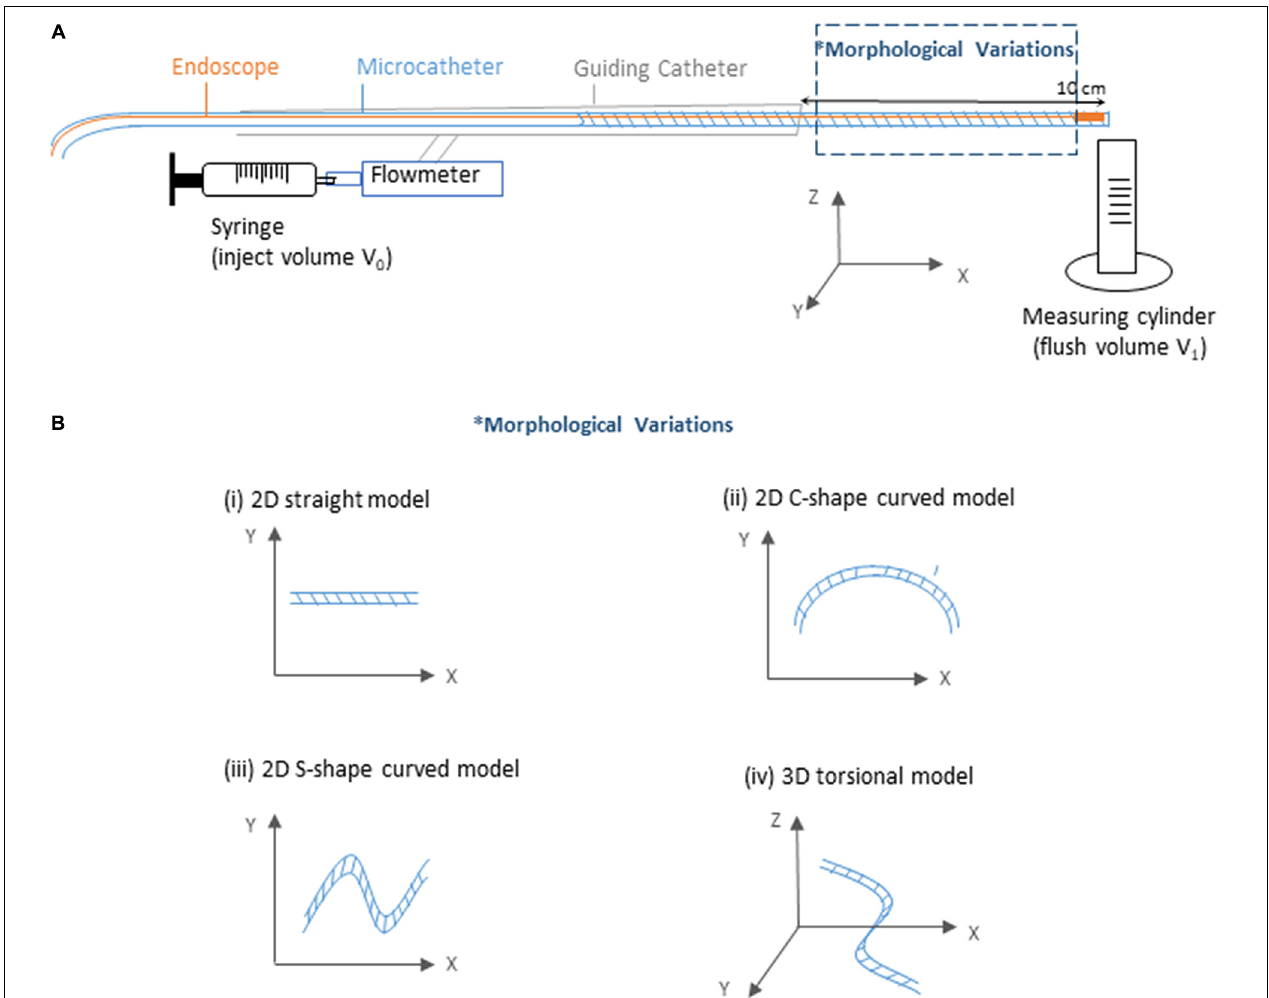
FIGURE 3 | Sketch of the experimental flow and measurement system. (A) Sketch of the experiment platform. (B) Sketch of the morphological variations of the